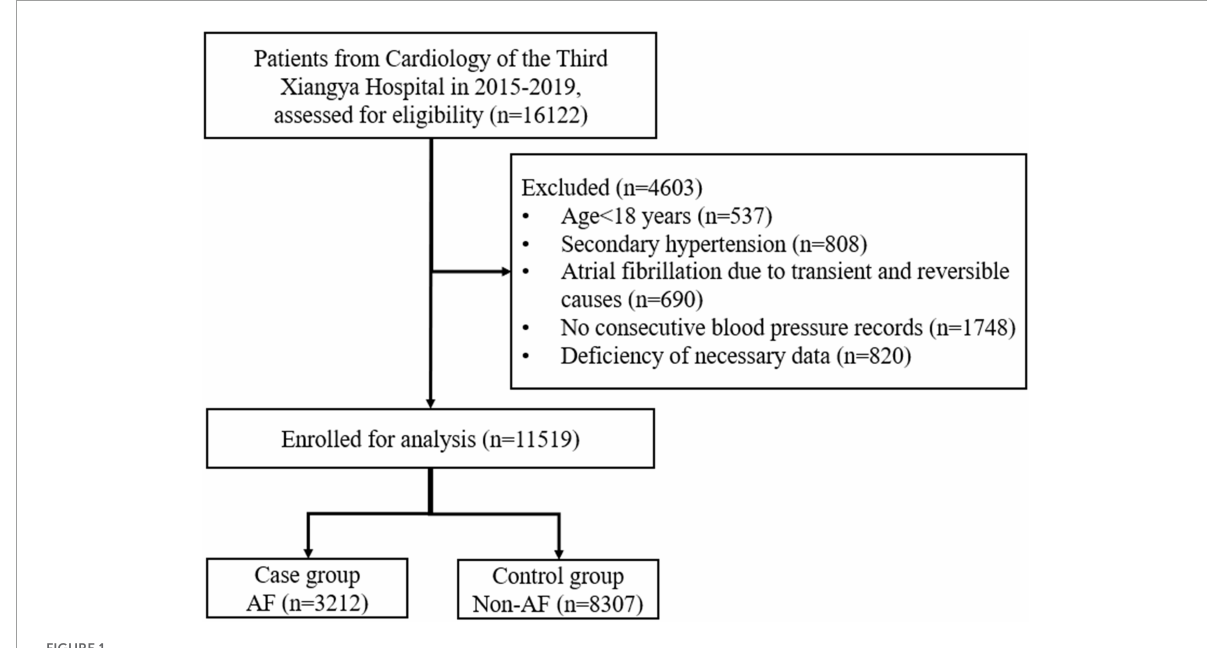
FIGURE1 Flow chart of screening. AF, atrial